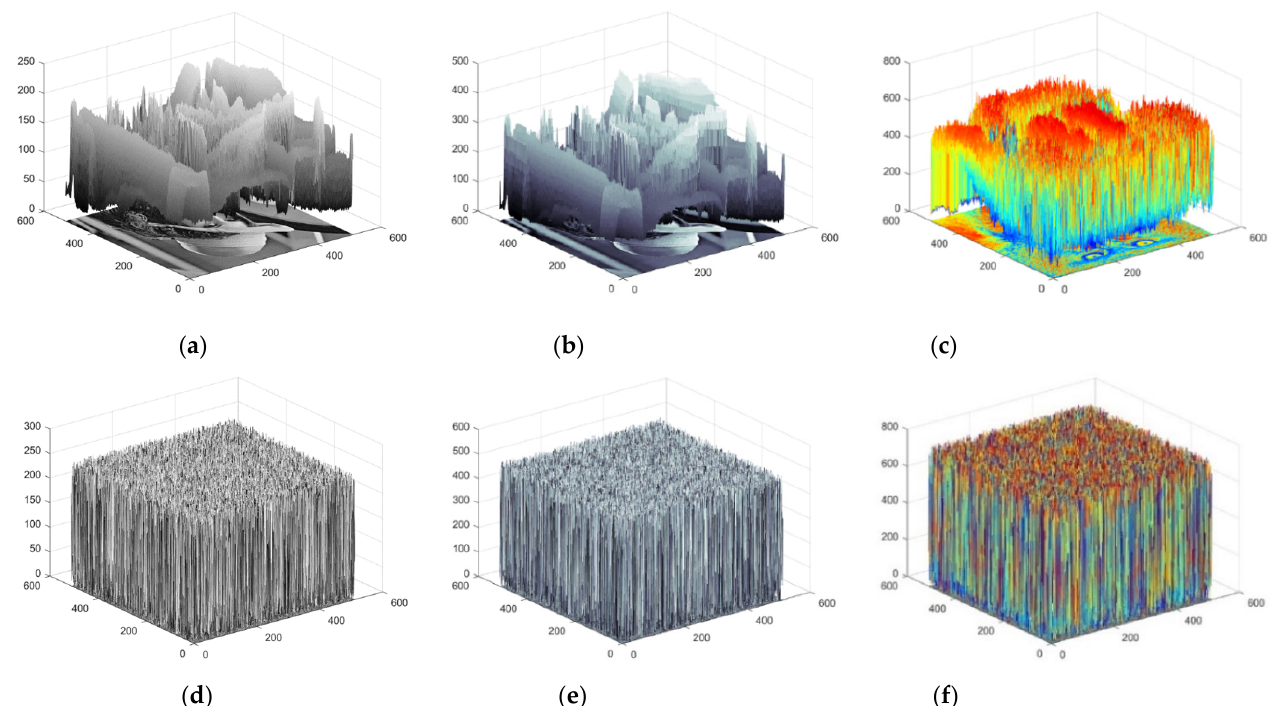
Figure 13. 3D histograms of the plain images and the cipher images: ( a ) Histogram of 8BPP Lena; ( b ) Histogram of 16BPP Lena; ( c ) Histogram of 24 BPP Baboon; ( d ) Histogram of 8BPP Lena’s cipher image; ( e ) Histogram of 16BPP Lena’s cipher image; ( f ) Histogram of 24 BPP Baboon’s cipher image.